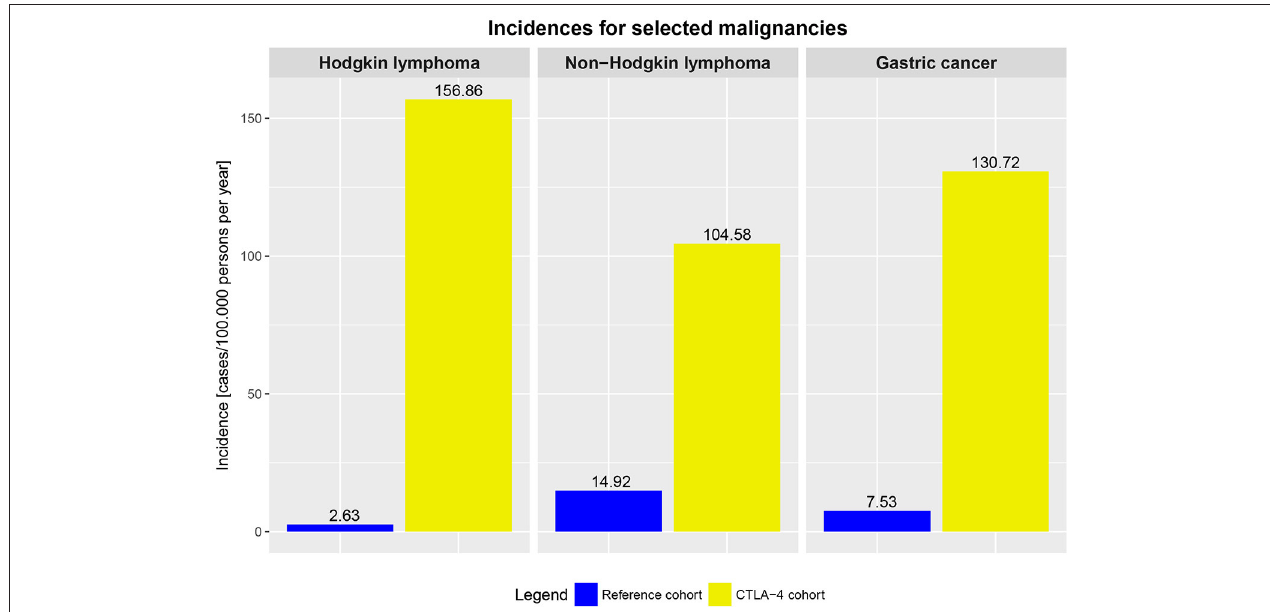
FIGURE 5 | Incidences of selected malignancies in the averaged German and US population (reference cohort, general population, 2009–2014) and incidences in affected CTLA4 mutation carriers (2009–2017).